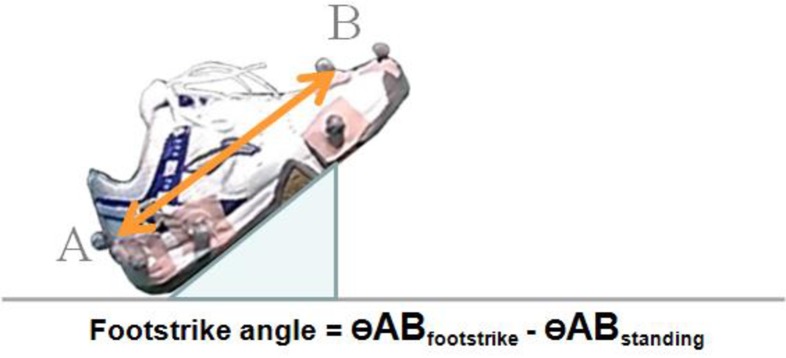
Definition of footstrike angle.